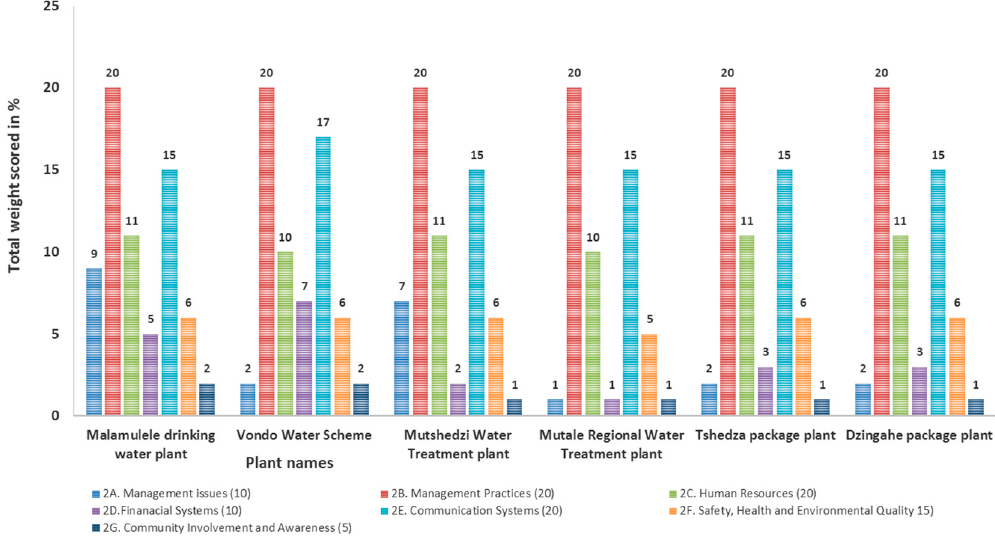
Figure 3. Scoring of water treatment plants based on the non-technical compliance assessment between August 2008 and June 2009.